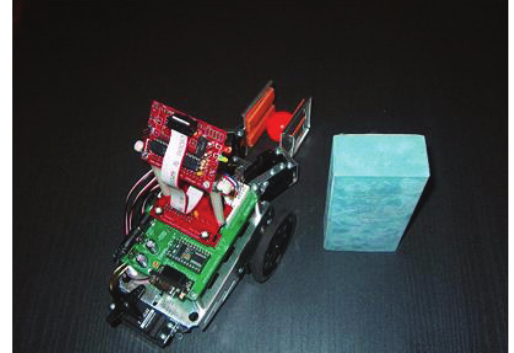
Figure 1: Experimental mobile robot with gripped target.